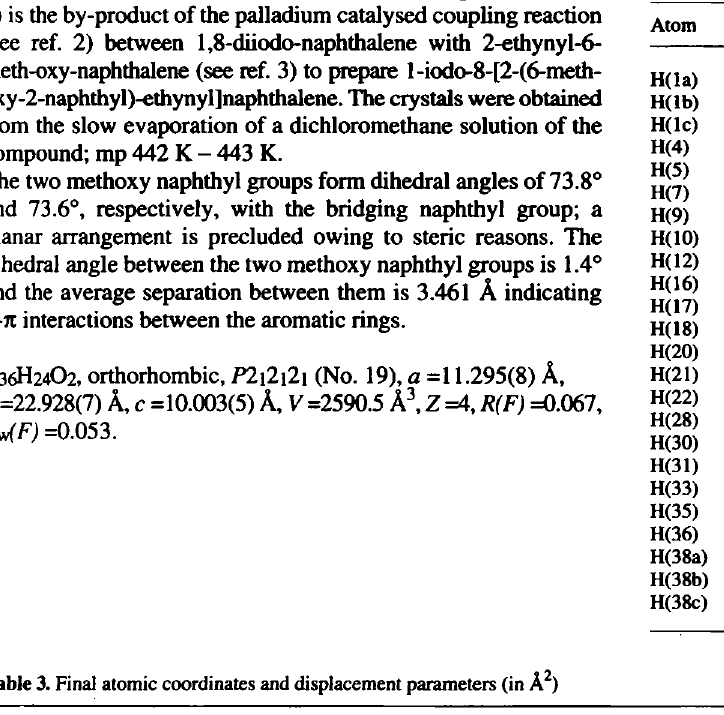
Table 3. Final atomic coordinates and displacement parameters (in